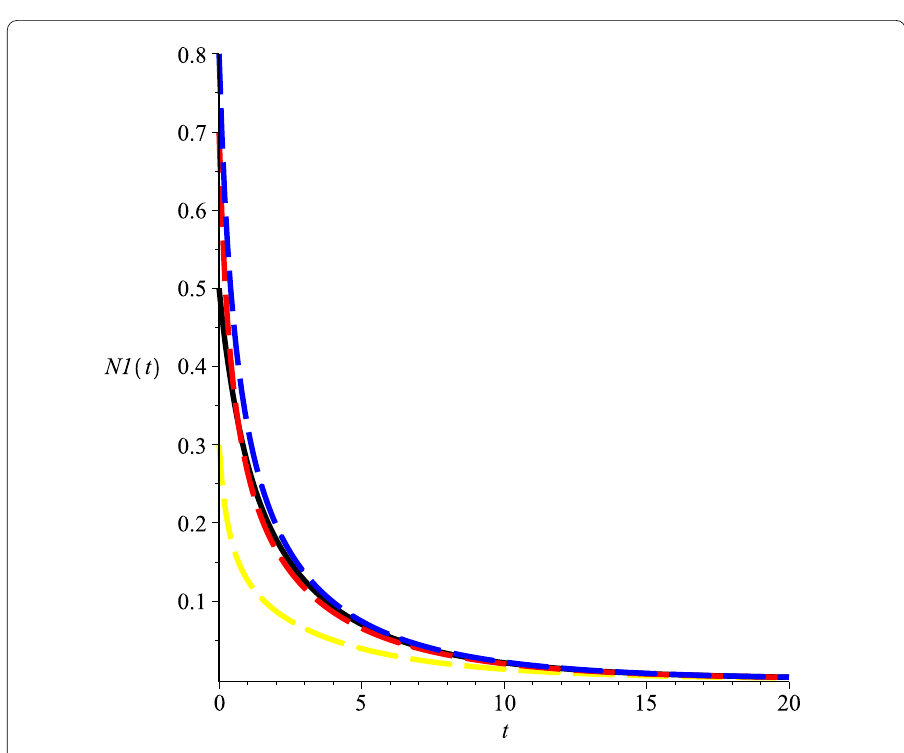
Figure 3 Numeric simulations of the first components of system (5.1) with m = 0.6, the initial conditions ( x (0), y (0)) = (0.5,0.1),(0.8,1),(0.3,3), and (0.7,2),